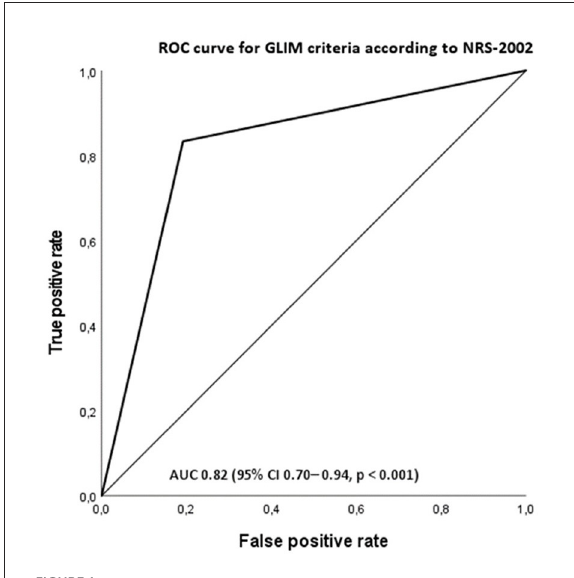
FIGURE1 Receiver operating characteristic curve (ROC) for GLIM-diagnosed malnutrition as a measure of malnutrition according to patient-subjective global assessment (PG-SGA) group BC. The area under the curve (AUC) is 0.805 (95% CI 0.68–0.93, p < 0.001).